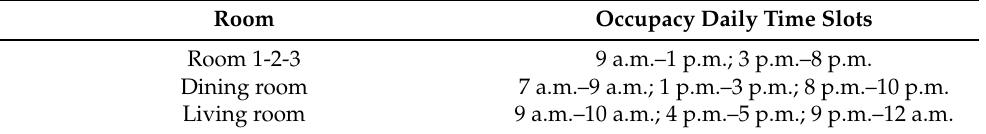
Table 7. Scheduled daily occupancy of each